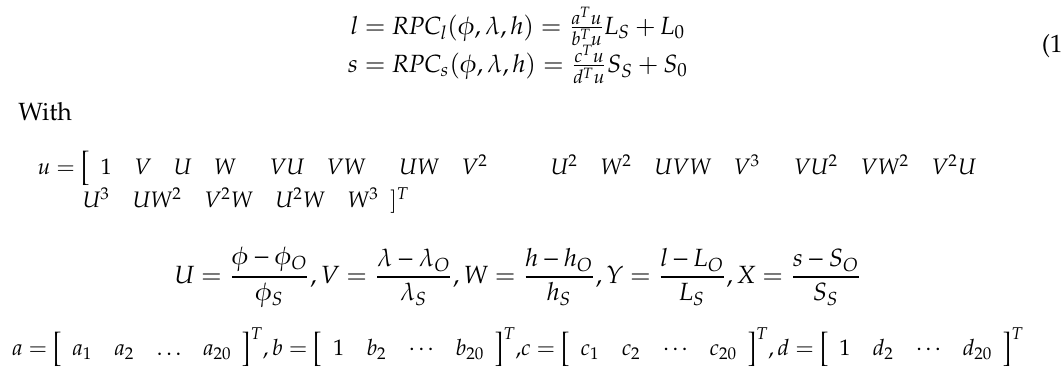
Figure 3. Quasi-ground control point (GCP) reconstruction and reprojection.